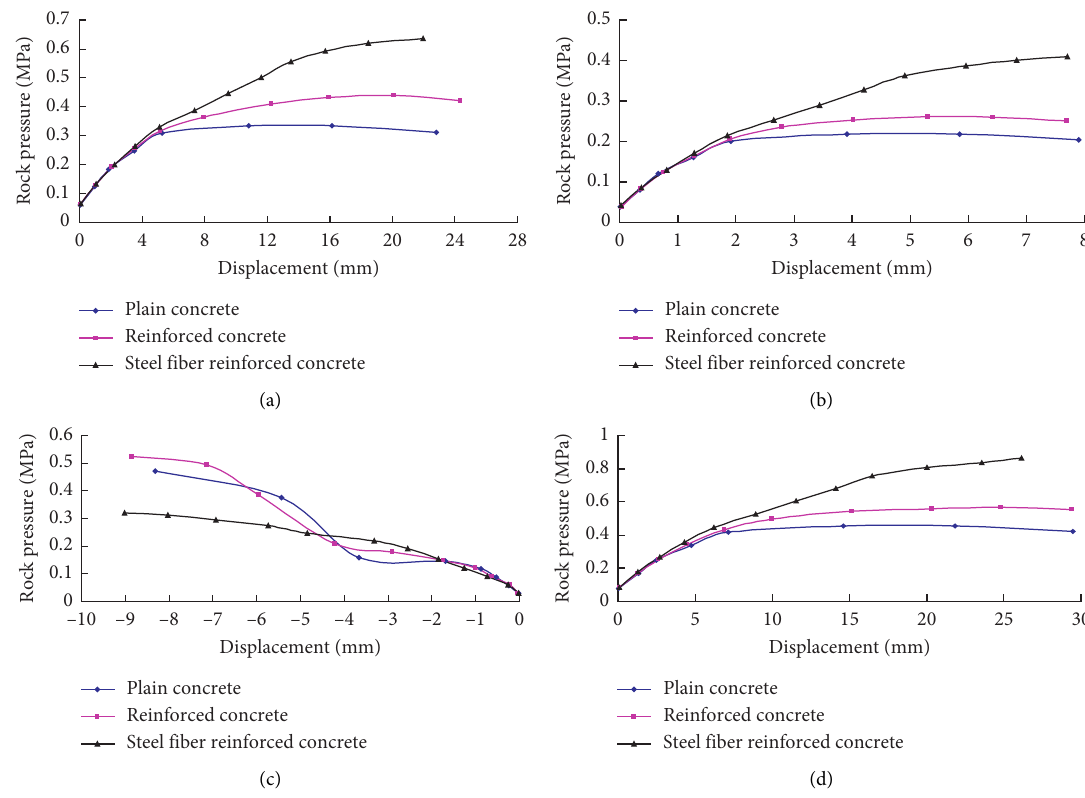
Figure 16: Bearing characteristic curves of lining structure. (a) Measuring point 1(vault). (b) Measuring point 2(haunch). (c) Measuring point 3(middle of the side wall). (d) Measuring point 4(middle of the inverted